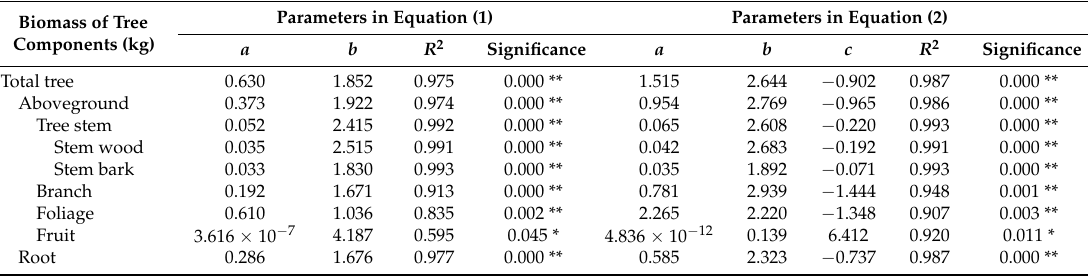
Table 2. Allometric biomass equations for individual components of Mongolian pine ( Pinus sylvestris L. var. mongolica